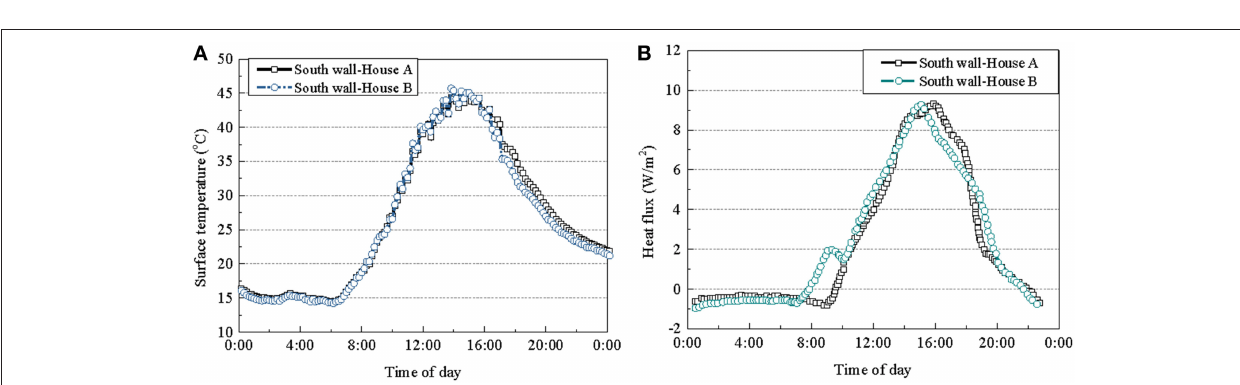
Frontiers in Energy Research |